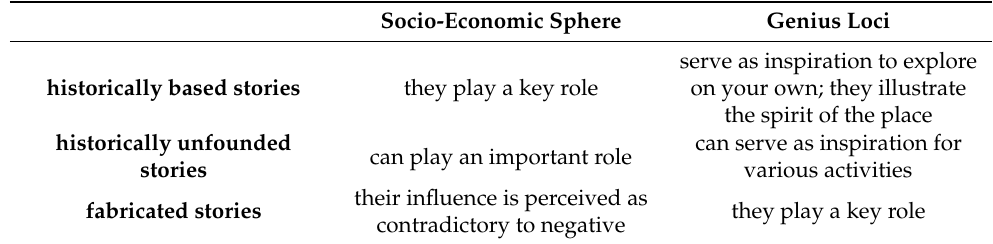
Table 2. The role that different story types play in genius loci and socio-economic sphere as landscape